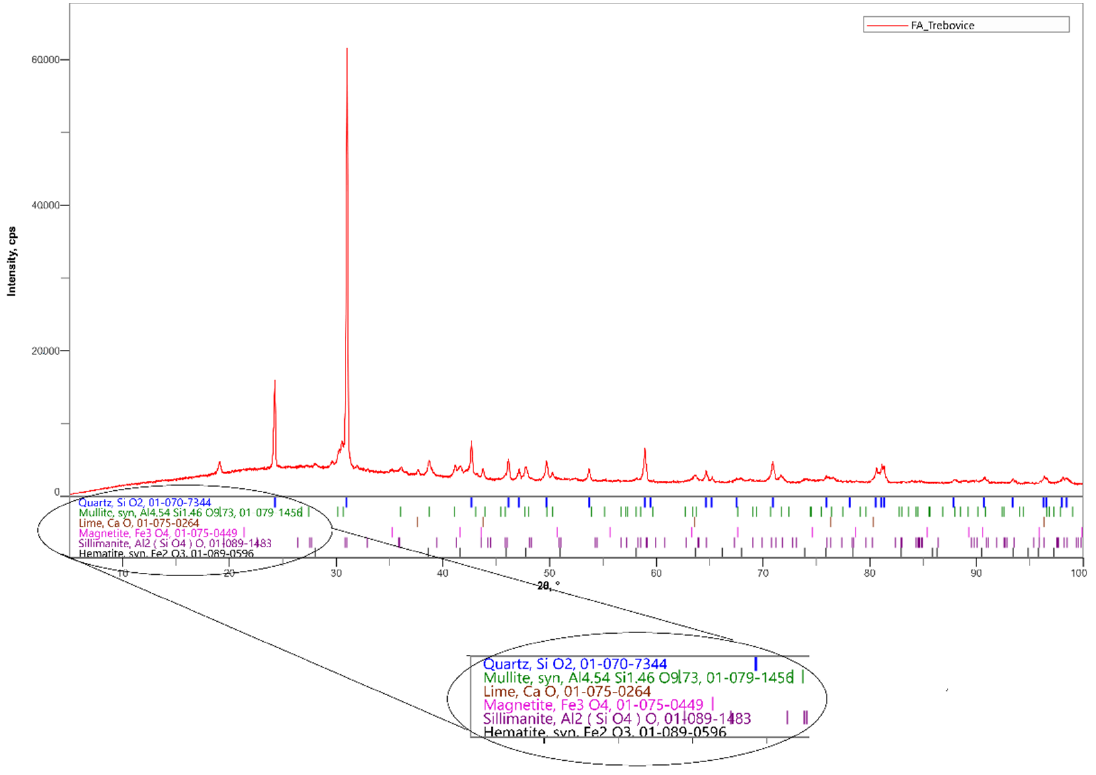
Figure 2. Mineralogical composition of fly ash determined by X-ray diffraction (XRD).